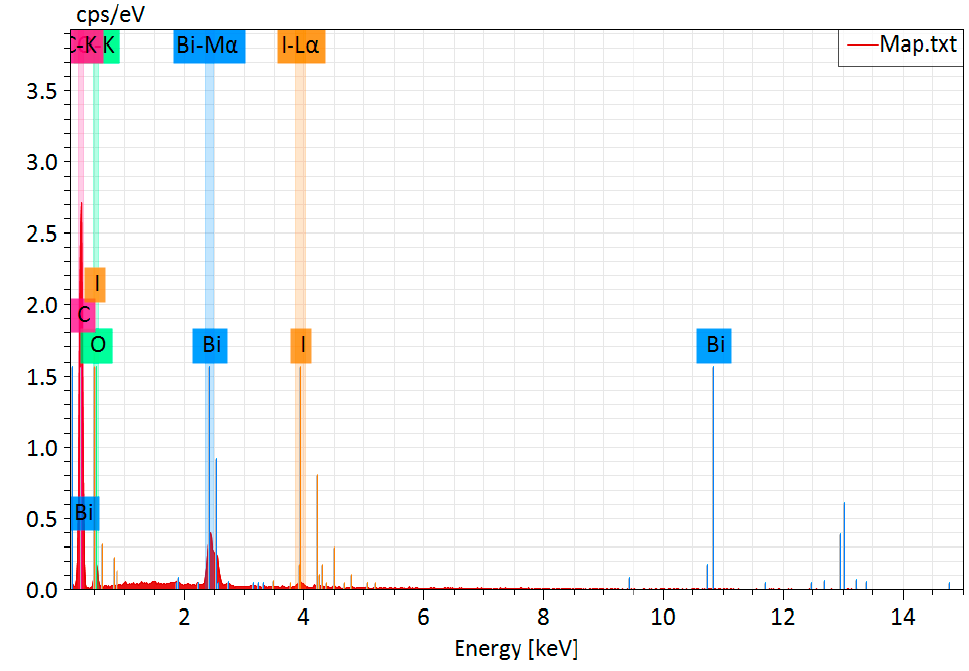
Figure 3. EDX spectrum of IBOCH-2.